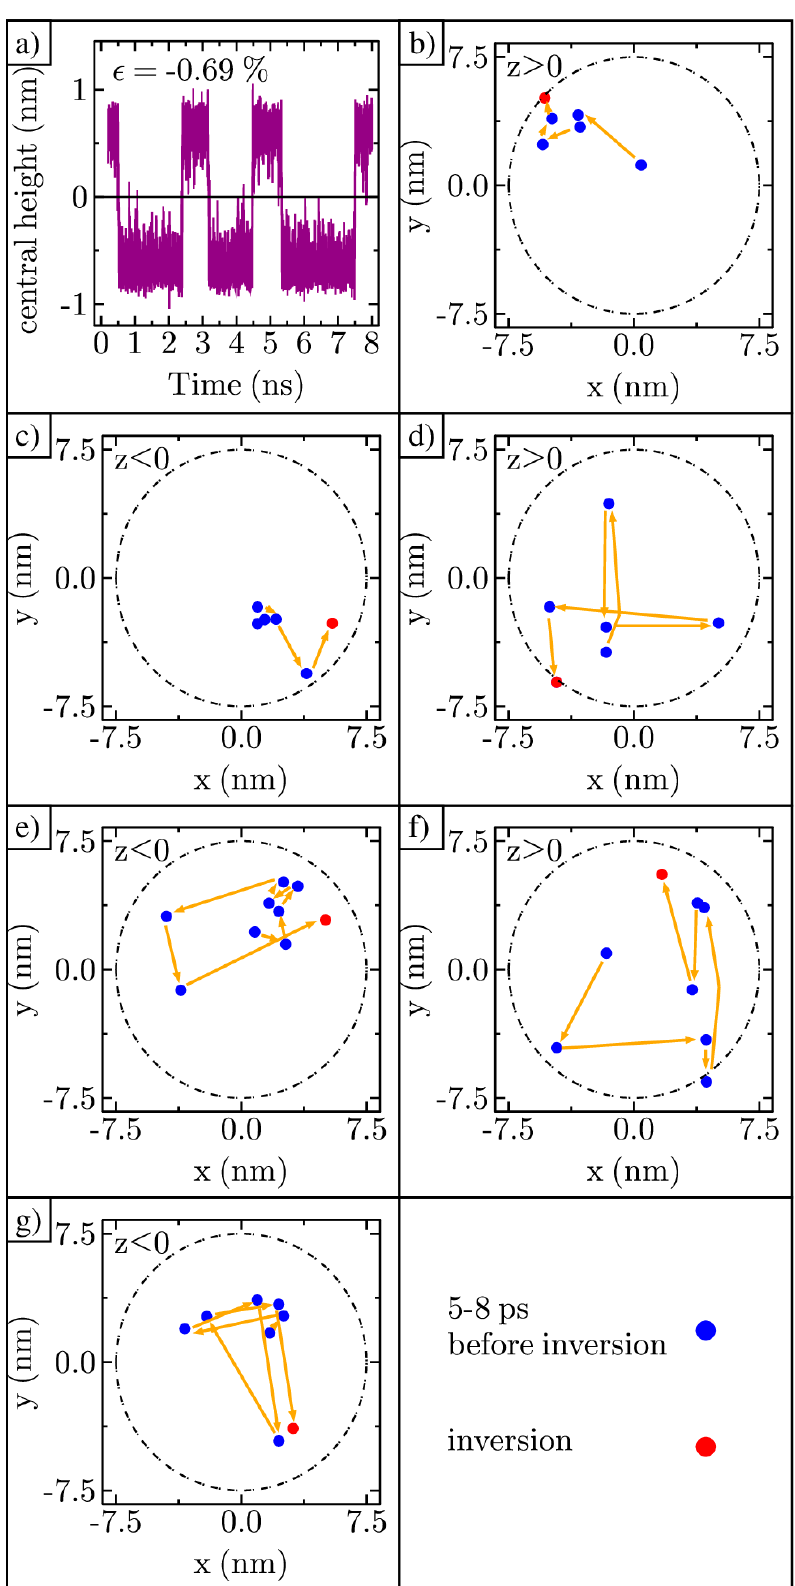
Figure 6. Ripple maximum shifts toward edge: ( a ) Central height of ripple in time with six complete inversions; ( b – g ) Displacement of the maximum along the x and y axes every picosecond, just before curvature inversion. Lower right box shows the legend.